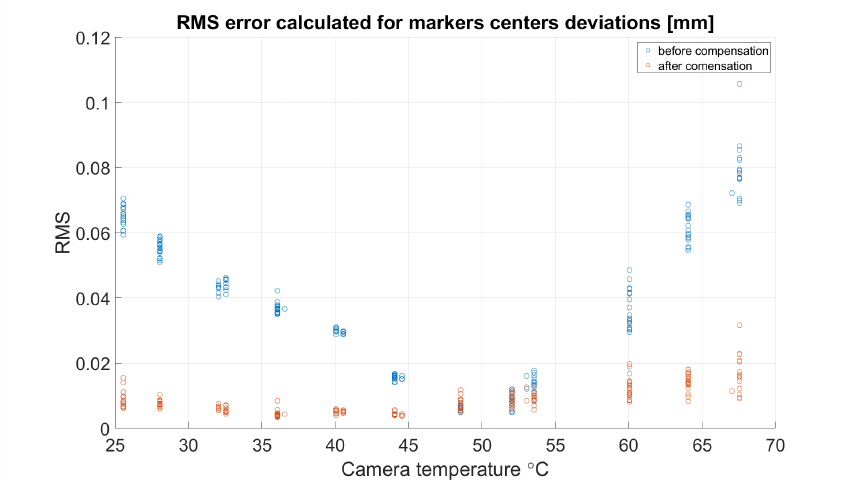
Figure 12. The RMS error calculated for marker center deviations before and after